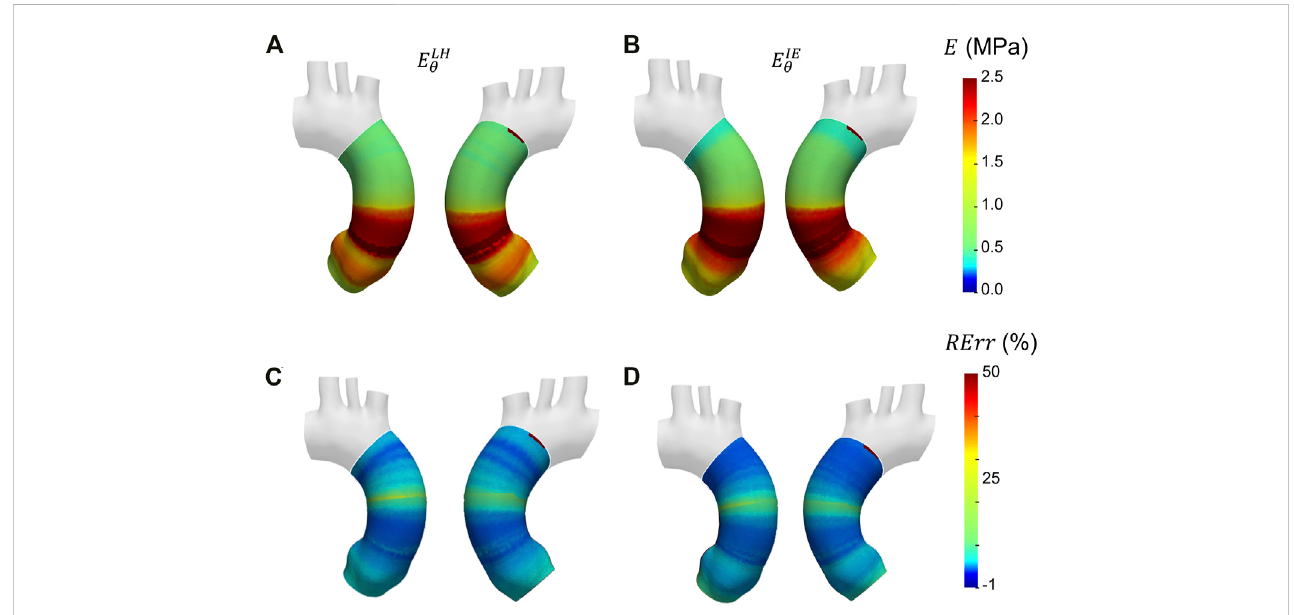
FIGURE 10 Young ’ s modulus maps of FE validation for patient-speci fi c geometry with proximal/distal distribution (A, B) with corresponding relative errors (C, D) . Both Laplace-hypothesis-based ( E LH θ ) (A, C) and inverse-engineering-based ( E IE θ ) (B, D) results are presented.